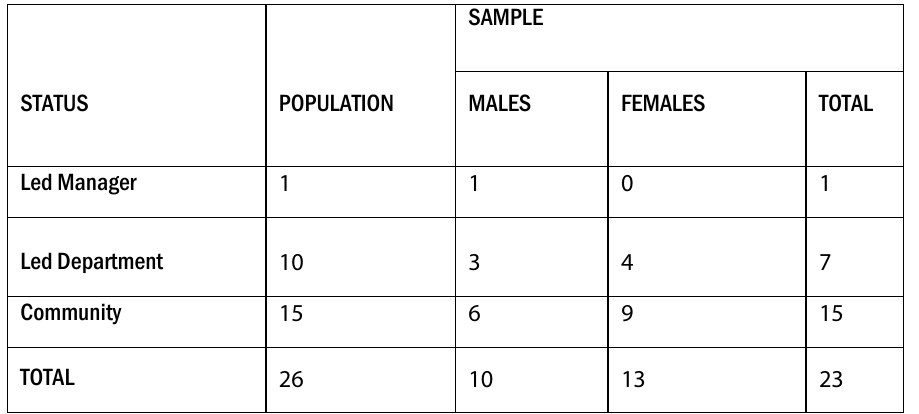
Table 1: Summary of respondent’s